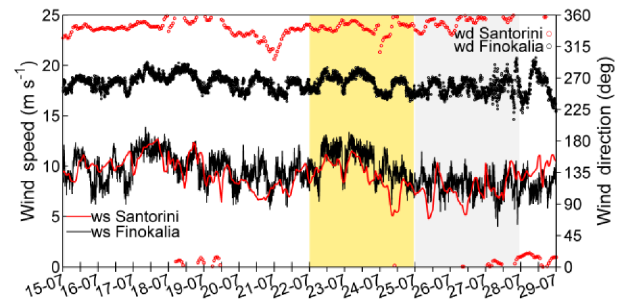
Figure 3. Time series of the wind speeds (ws, solid lines on left axis) and wind directions (wd, open circles, right axis) at Santorini (simulations from the WRF-Chem model) and at Finokalia (mea- surements). The second period of the EF is shaded with yellow and the MSF with grey.